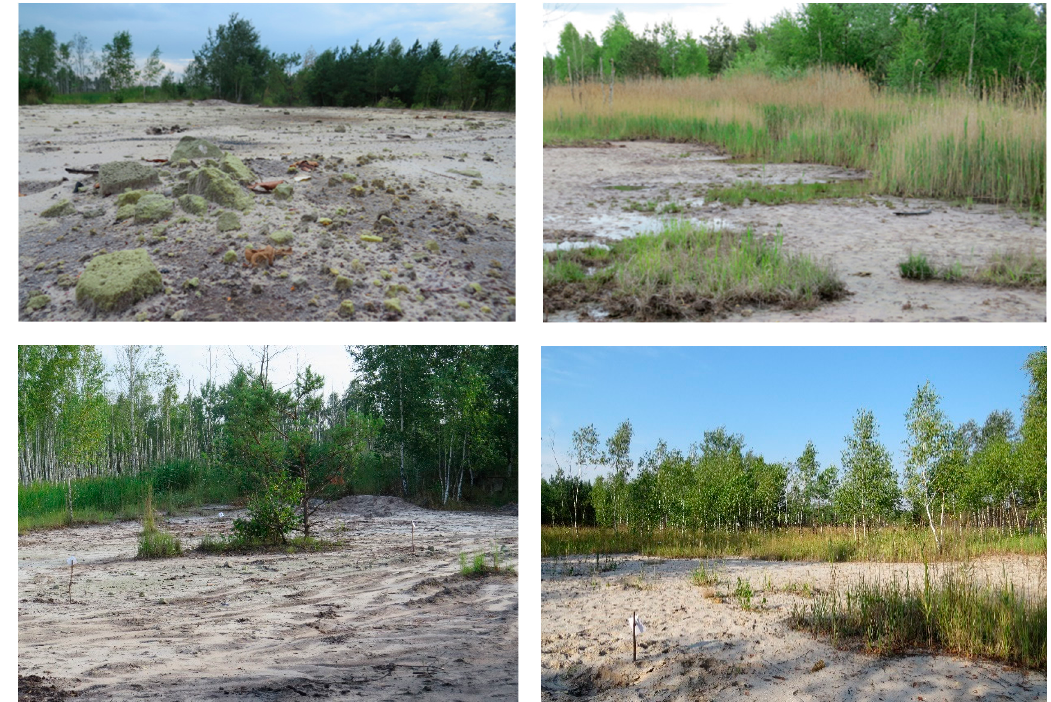
Figure 2. The Jeziórko former sulfur mine area − vegetation adaptation (photo: J. Likus-Cie ś lik). Figure 2. The Jezi ó rko former sulfur mine area—vegetation adaptation (photo: J. Likus-Cie´slik). The former Mach ó w sulfur mine and former Jezi ó rko sulfur mine are located in Southern Poland, near Tarnobrzeg. The region has an average annual temperature of 8.2 + 18.7 ◦ C in July), and the average annual precipitation ranges from 550 to 650 mm. The growing season lasts from 200 to 220 days per